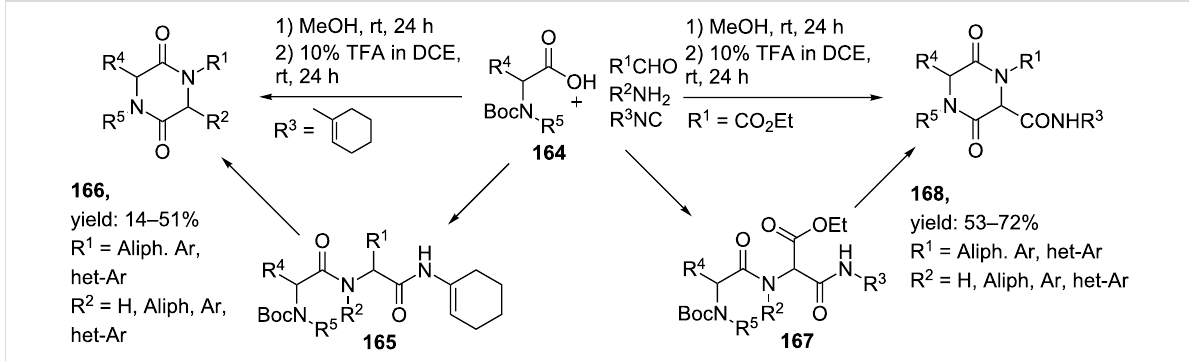
The DKP core shows properties for enhanced interaction with biological targets such as metabolic stability, conformational rigidity and the scaffold can both donate and accept hydrogen bonds. Furthermore, diversity can be introduced at four posi- tions (N1, N4, C3 and C6). An important feature of DKPs is that they are able to induce secondary structures such as β -turns, β -hairpins in β -sheets and α -helices [141]. Therefore, DKPs are often used as peptidomimetic building blocks. A more detailed review of diketopiperazines is published by Borthwick and Piarulli